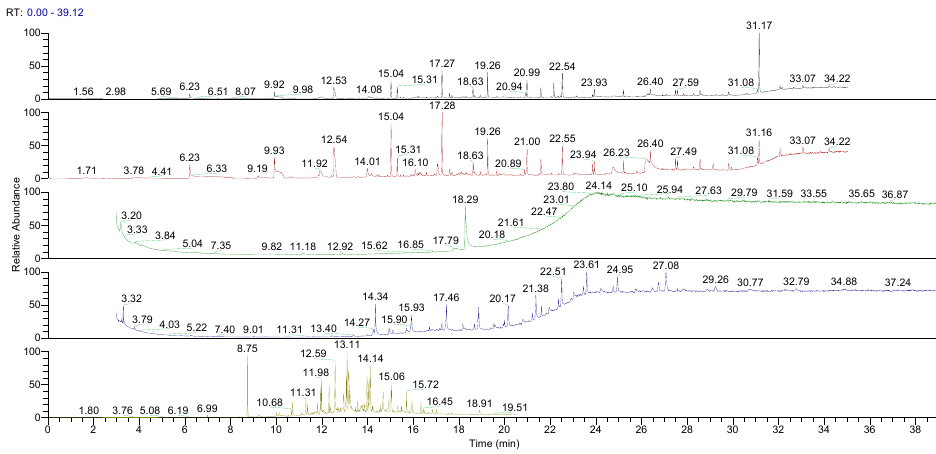
Figure 2. Chromatograms obtained by gas chromatography-mass spectrometry (GC/MS) of all the extraction methods on untreated linear low-density polyethylene (LLDPE) single dose containers. From the top: Sonication pH 2, sonication pH 10, Sealed Vessel, Soxhlet, and HS SPME (Head Space Solid Phase microextraction).